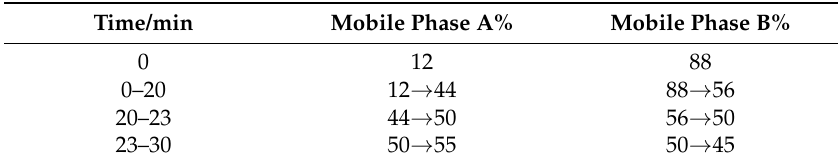
Table 5. Proportion of gradient elution mobile